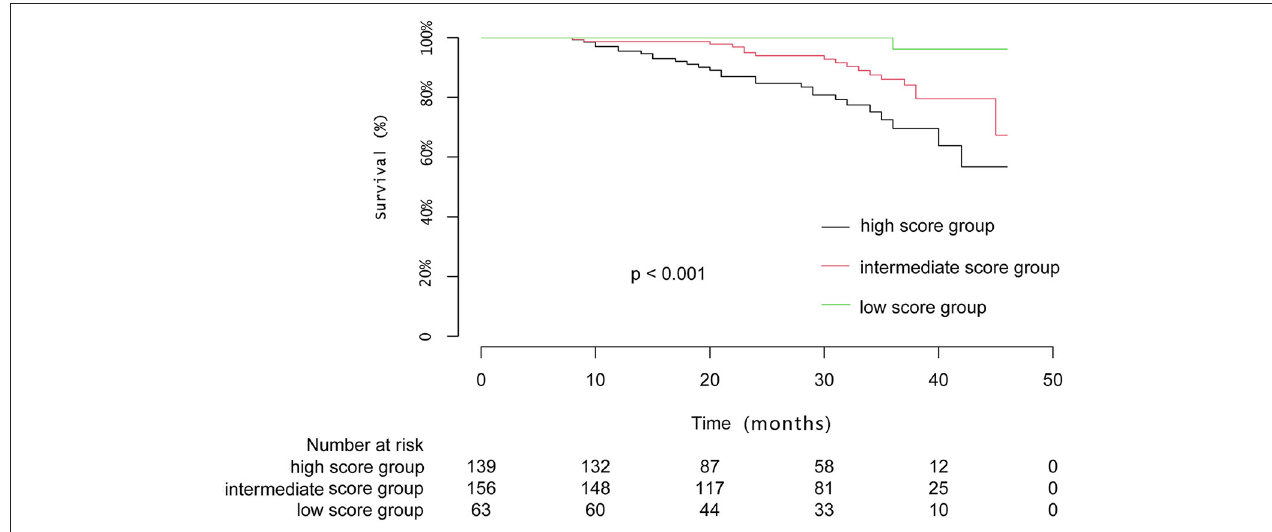
FIGURE 3 | Mortality stratified by the low, intermediate, and high HFA-PEFF scores.